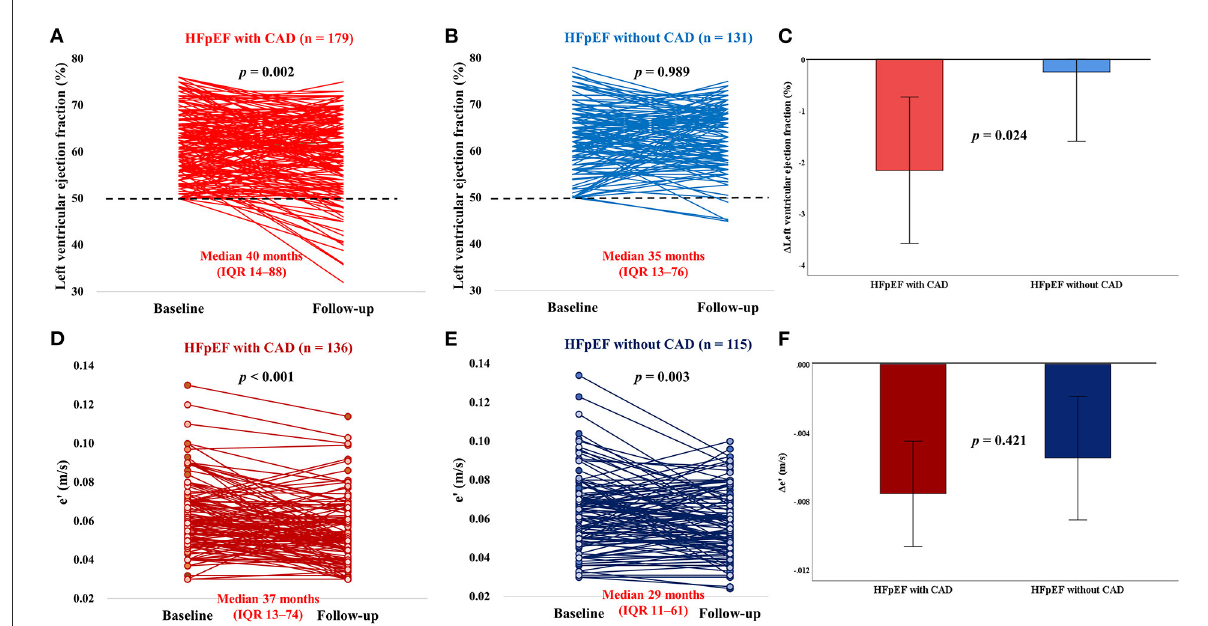
FIGURE2 Impact of CAD on longitudinal changes in LVEF and e’. CAD, coronary artery disease; HFpEF, heart failure with preserved ejection fraction; LVEF, left ventricular ejection fraction; e’, mitral annulus early diastolic velocity. (A–C) In patients with HFpEF without significant CAD, there was no longitudinal change in EF, whereas in patients with CAD, there was a reduction in LVEF, with multiple patients developing reduced LVEF ( < 50%, dotted lines). (D–F) The e’ was significantly decreased in both HFpEF patients with CAD and without CAD, and there were no significant diffrences in the decline of e’ between the two groups.